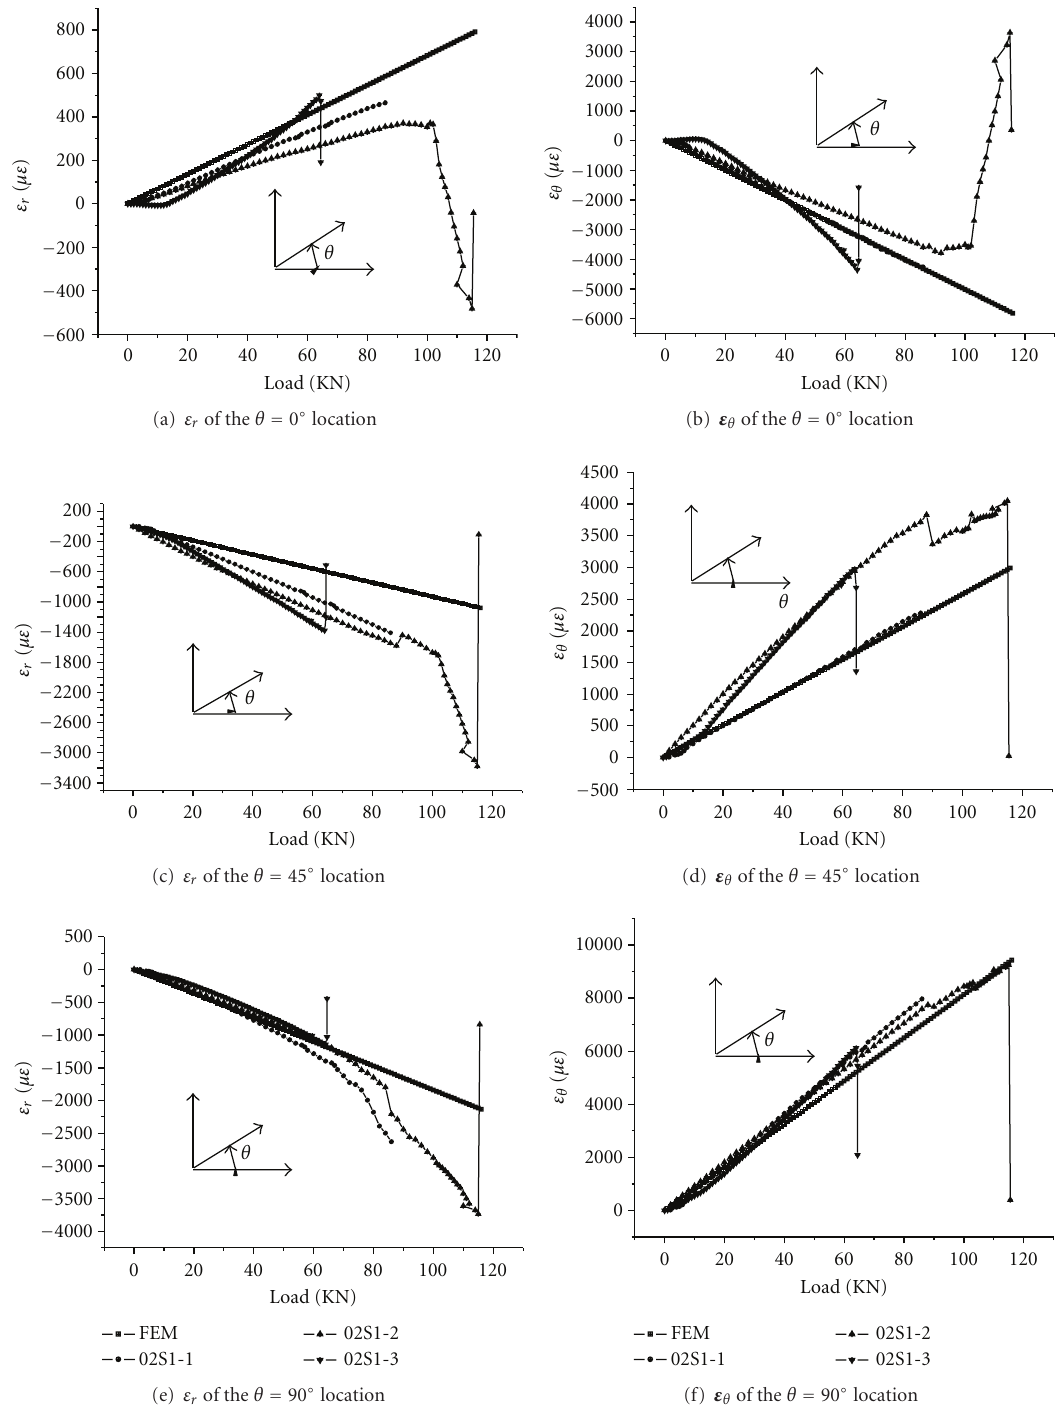
Figure 13: Strain of unstitching along the circle with r = 32 .